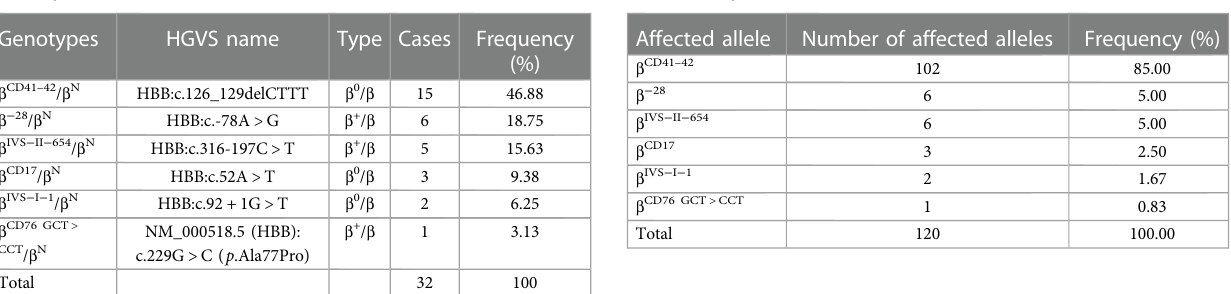
TABLE 6 Allele frequencies of β -thalassemia mutations in the newborns of Li in Hainan